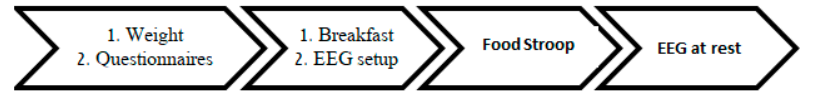
Figure A1. Procedures’ timeline.